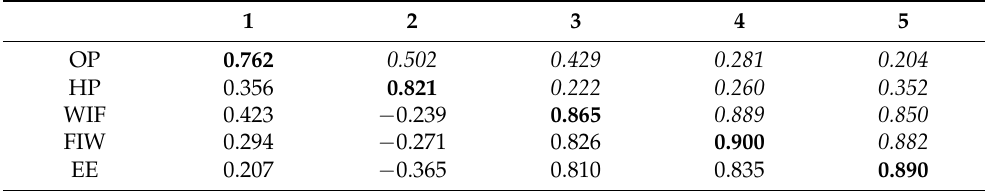
Table 3. Fornell–larcker and HTMT results.